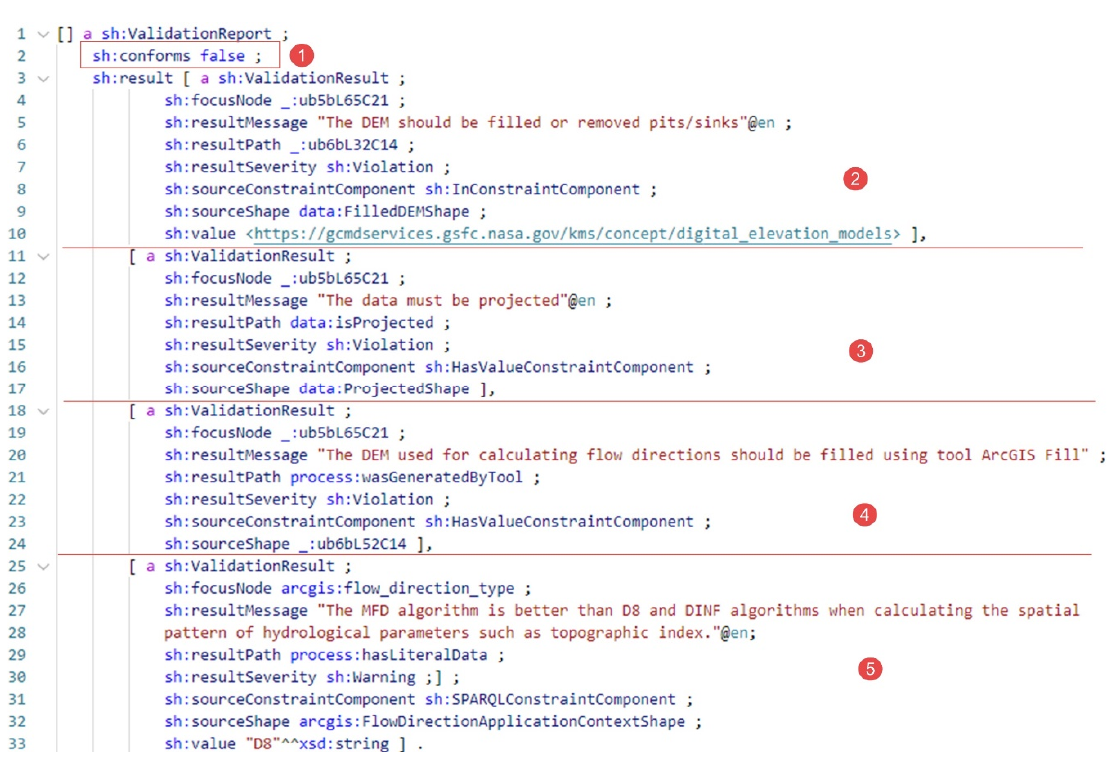
Figure 8. Validation report of the input data against the shapes of the Flow Direction tool. Part (1) represents the conformance of the inputs as a whole, parts (2)–(5) represent the validation results of the inputs against the data theme constraint, map projection constraint, provenance constraint, and application-context-matching constraints, respectively.